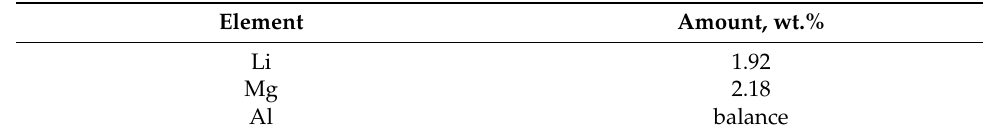
Table 1. The results of the chemical analysis.